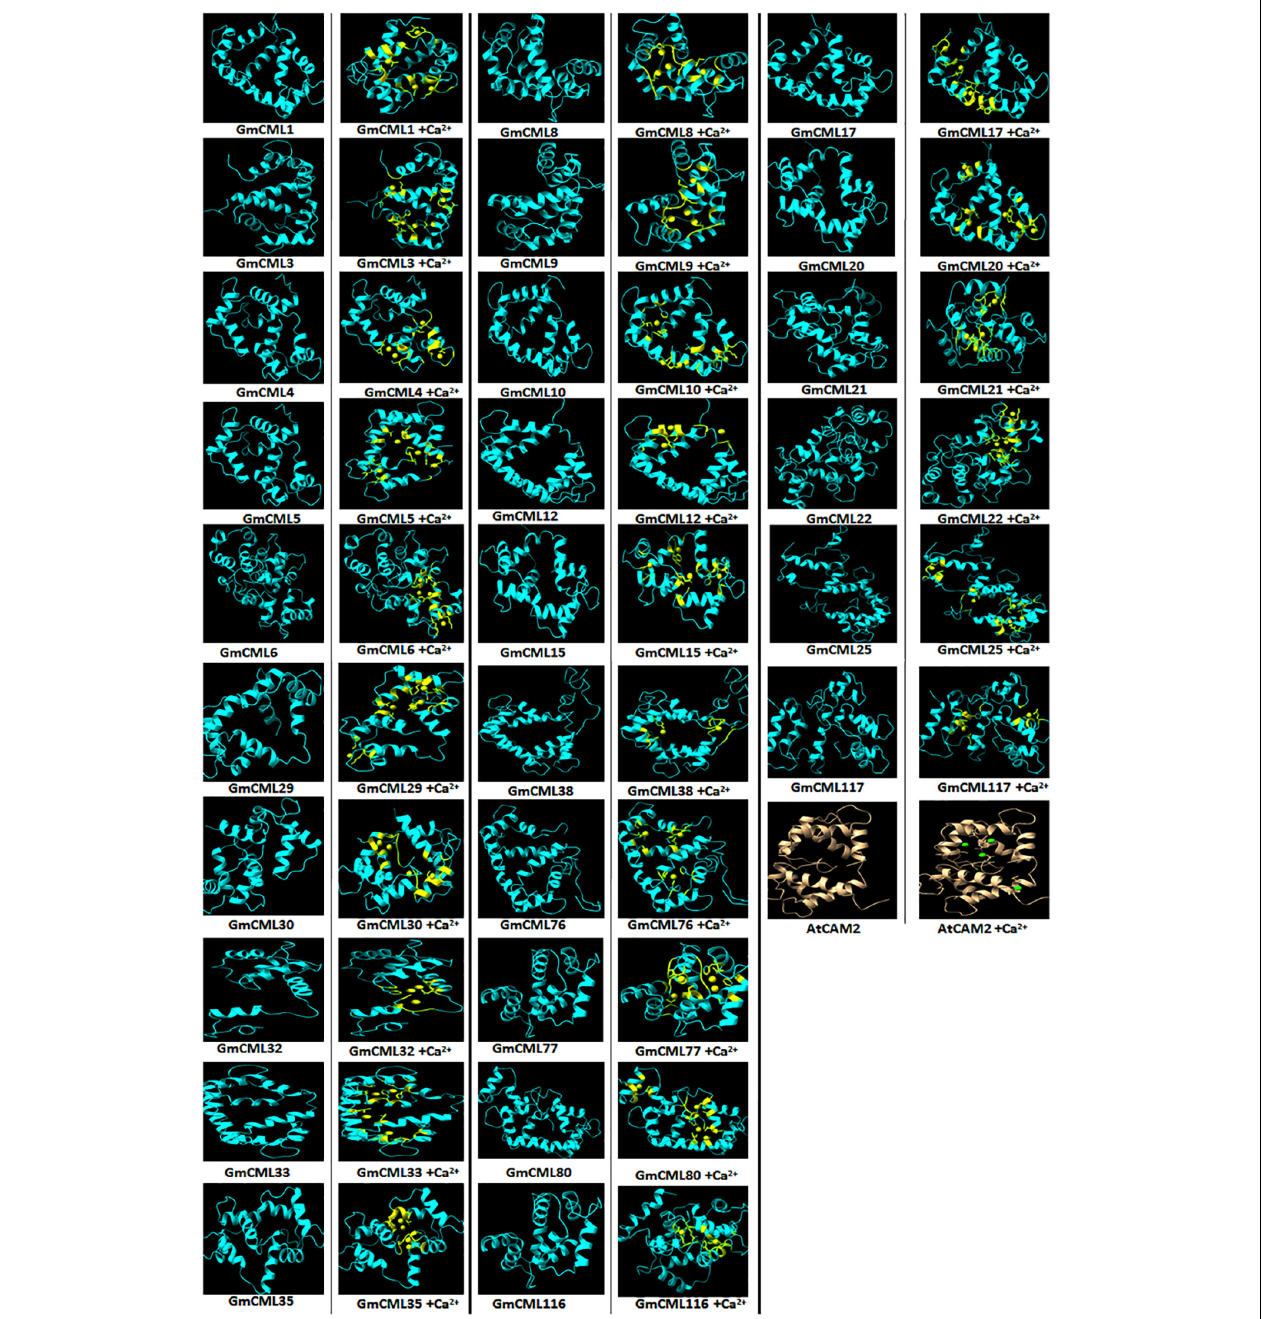
FIGURE 9 | Interaction of GmCMLs with Ca 2 + using molecular docking and their comparison with interaction of Calmodulin 2 ( A. thaliana) with Ca 2 + . The figure shows the modeled tertiary structures of GmCMLs and their interaction with Ca 2 + , wherein the yellow balls indicate Ca 2 + and the yellow-colored segments in the model represent EF-hands. The number of Ca 2 + showing interaction with GmCMLs varied according to the number of EF-hands. The global docking energy score of interaction between 26 GmCMLs with Ca 2 + is shown to have near to global docking energy score of interaction between Calmodulin 2 of A. thaliana with Ca 2 + . The tertiary structure of A. thaliana is shown in gray color and the green balls indicate Ca 2 +